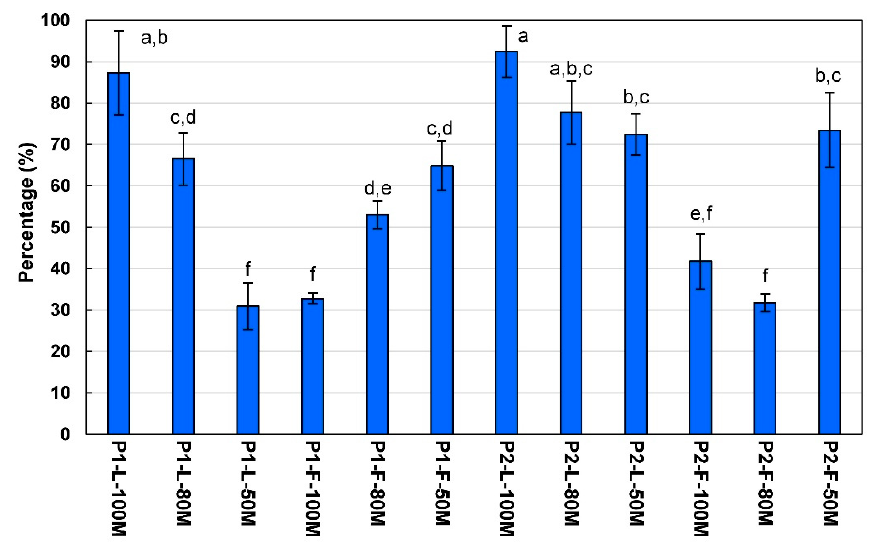
Figure 1. Average percentage of total flavonoid content from the total phenolic content of methanolic extracts from Verbesina sphaerocephala leaves and flowers. Bar plot represents mean ± standard deviation of three repetitions. Different letters indicate significant differences between groups within homogeneous subsets (Tukey, p < 0.05). Abbreviations: P1, Population 1; P2, Population 2; L, leaves; F, flowers; 100M, extracted with 100% methanol; 80M, extracted with 80% methanol; 50M, extracted with 50% methanol.